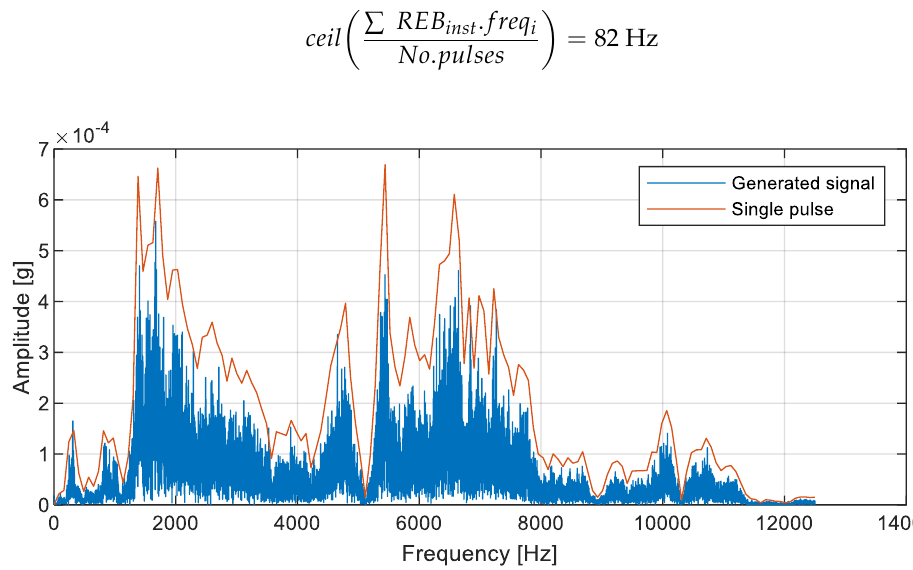
Figure 14. Full-resolution spectrum of generated vibration signals.